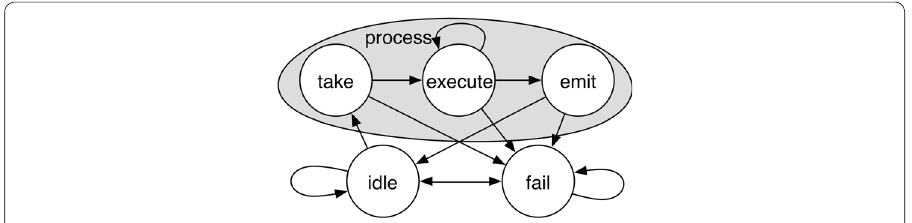
Fig. 7 Finite state automaton describing bolt